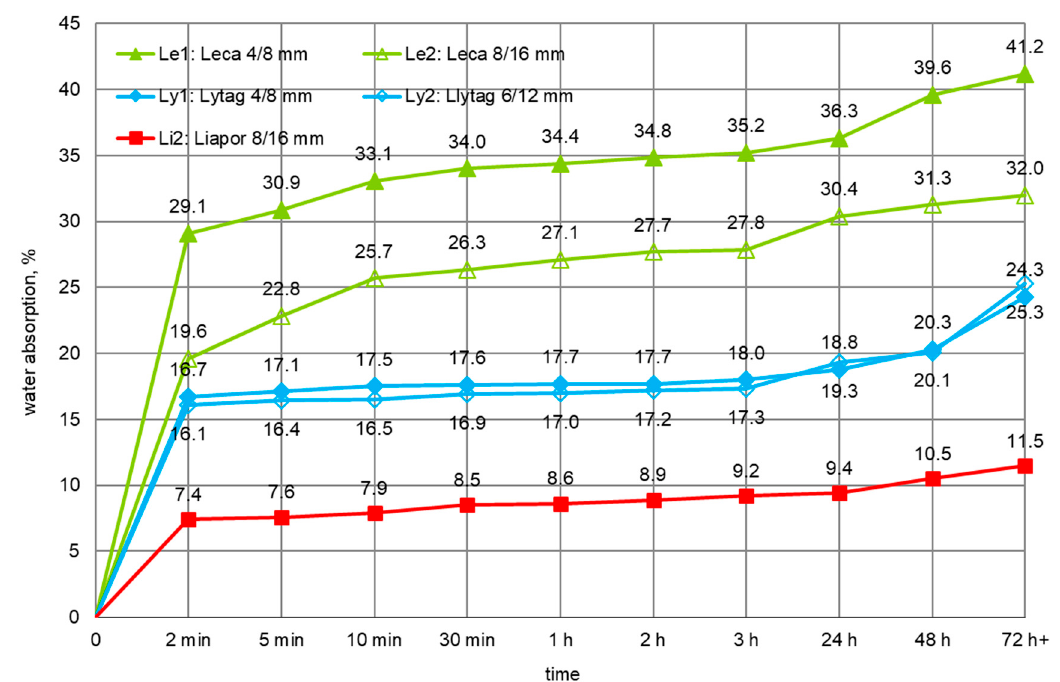
Figure 7. Development of water absorption of plain lightweight aggregates in time.